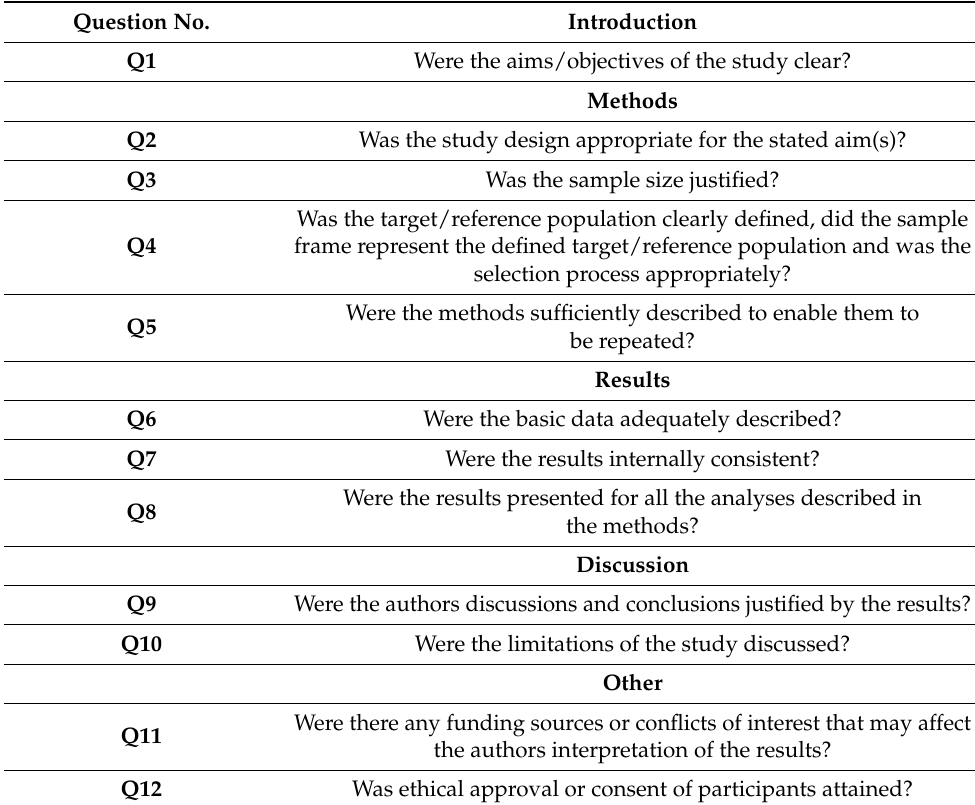
Table 1. Modified AXIS tool